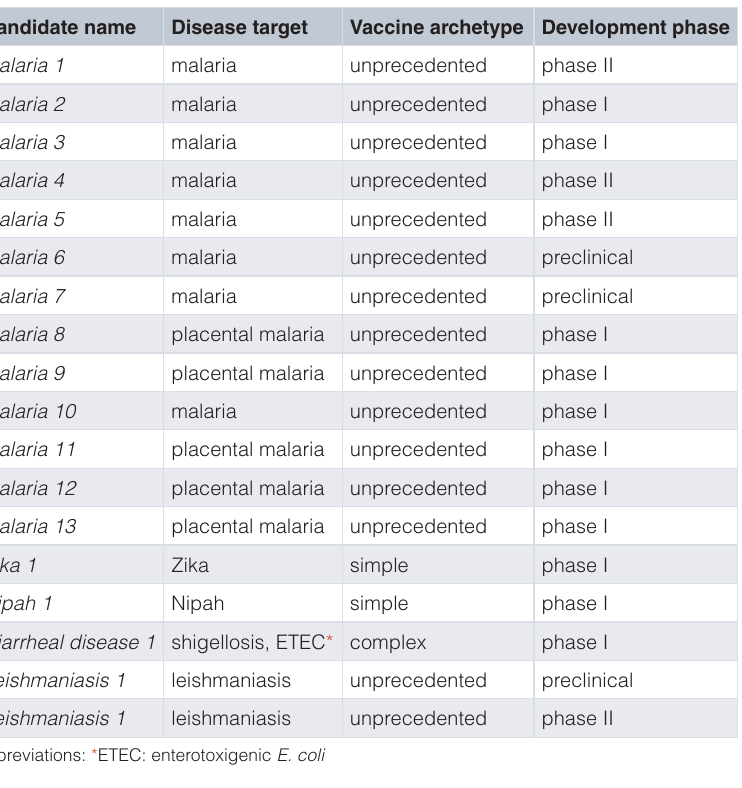
Table 1. List of vaccine candidates, disease target, product archetype, and current development phase for EVI’s